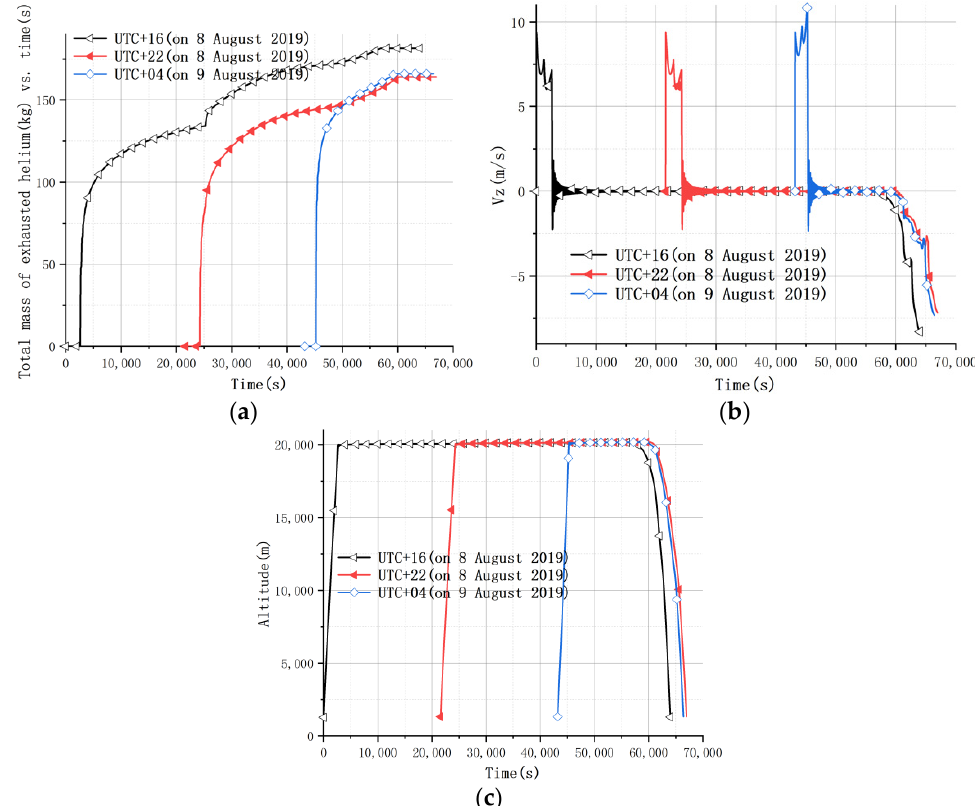
Figure 11. Diagrams corresponding to different launch times. ( a ) shows the total mass of exhausted helium vs. time, ( b ) shows the change in vertical velocity, and ( c ) shows the change in altitude.